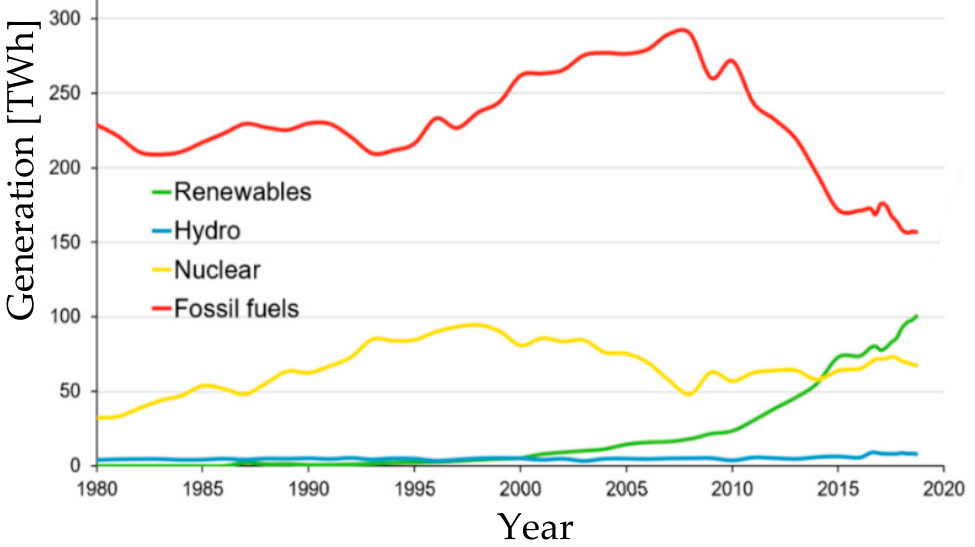
Figure 1. United Kingdom electricity production by source: 1980–2018 [2].